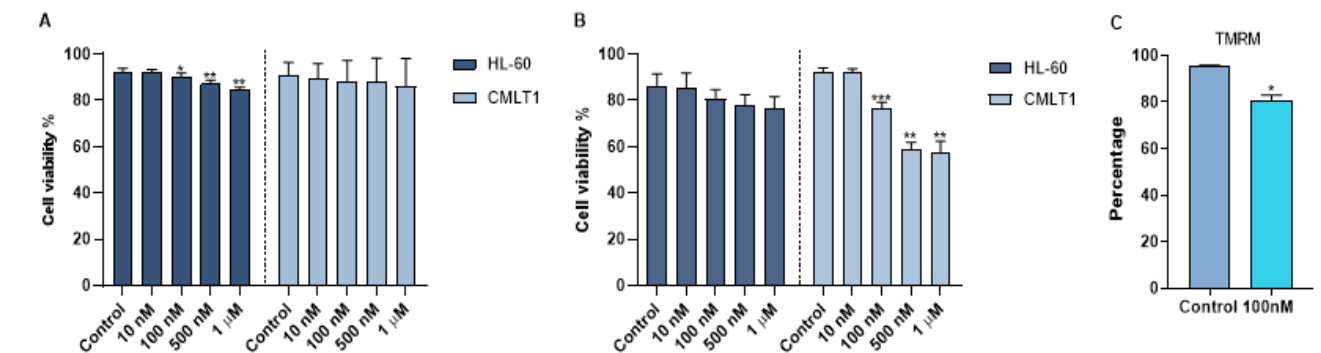
Figure 4. Apoptosis assay following IL-VX and free venetoclax treatment. In ( A ) treatment of CD26+ CMLT1 cells with different concentrations of free venetoclax did not induce any apoptotic effect and just a minor apoptotic effect was seen in HL60 as CD26 − cells. However, IL-VX significantly enhanced apoptosis in CMLT1 starting from 100 nM while sparing CD26 − HL60 cells ( B ). Reduction of TMRM fluorescent signal (which indicates reduction of mitochondria membrane potential) was seen in CMLT1 treated with 100 nM of IL-VX ( C ). This result confirms the apoptotic effect of IL-VX in CD26+ CMLT1 cells. (* p < 0.05, ** p < 0.01 and *** p < 0.001).